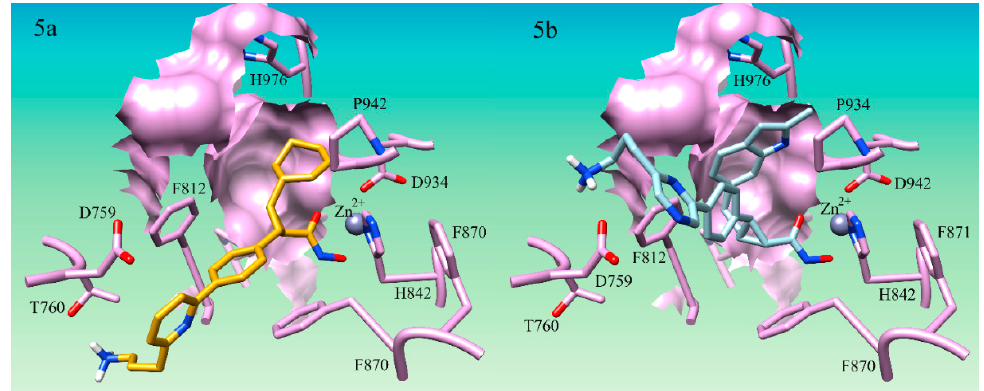
Figure 5. Docking pose of H16 and H15 in HDAC4 active site. ( 5a ) Docking pose of compound H16 (gold) in HDAC4 active site Hydrogen bond interaction between cationic nitrogen and T760 is shown; ( 5b ) Docking pose of compound S25d-03 (light blue) in HDAC4 active site. Cationic nitrogen is shown forming an electrostatic interaction with D759 in the active site.